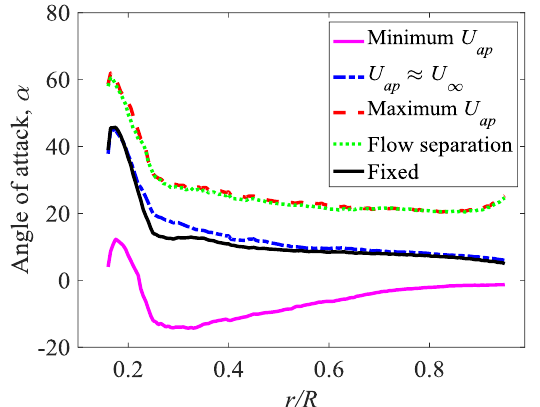
Fig. 15. Angle of attack 𝛼 profiles along the blade for fixed and surging turbine corresponding to the minimum 𝑈 𝑎𝑝 , 𝑈 𝑎𝑝 ≈ 𝑈 ∞ , maximum 𝑈 𝑎𝑝 , and when the greatest flow separation occurs.